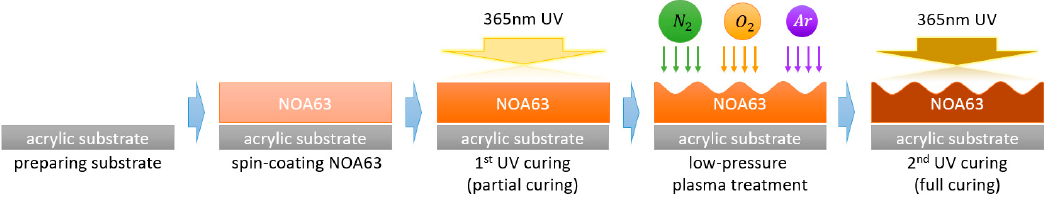
Figure 2. A schematic of the procedure to generate diverse wrinkle structures by low-pressure plasma treatment. The plasma was produced from nitrogen, oxygen, and argon gases under a low pressure. Table 1. Working pressure depending on plasma gas (nitrogen, oxygen, and argon) and its flow rate. Plasma Gas. N 2 O 2 Flow Rate (sccm)